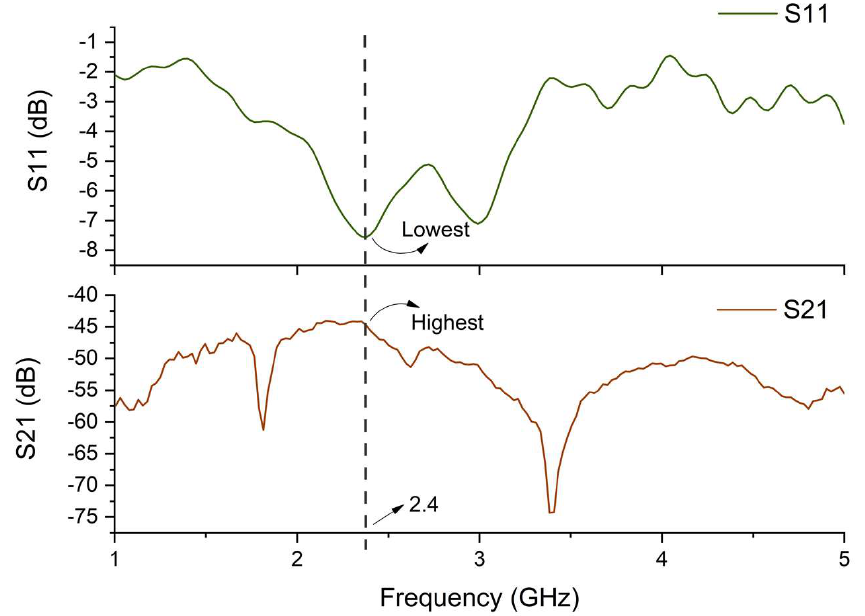
Figure 8. S 11 ( top ) and S 21 ( bottom ) parameters measured through the VNA for a frequency range of 1 to 5 GHz, which demonstrates that the antenna is better suited to operate at 2.4 GHz.